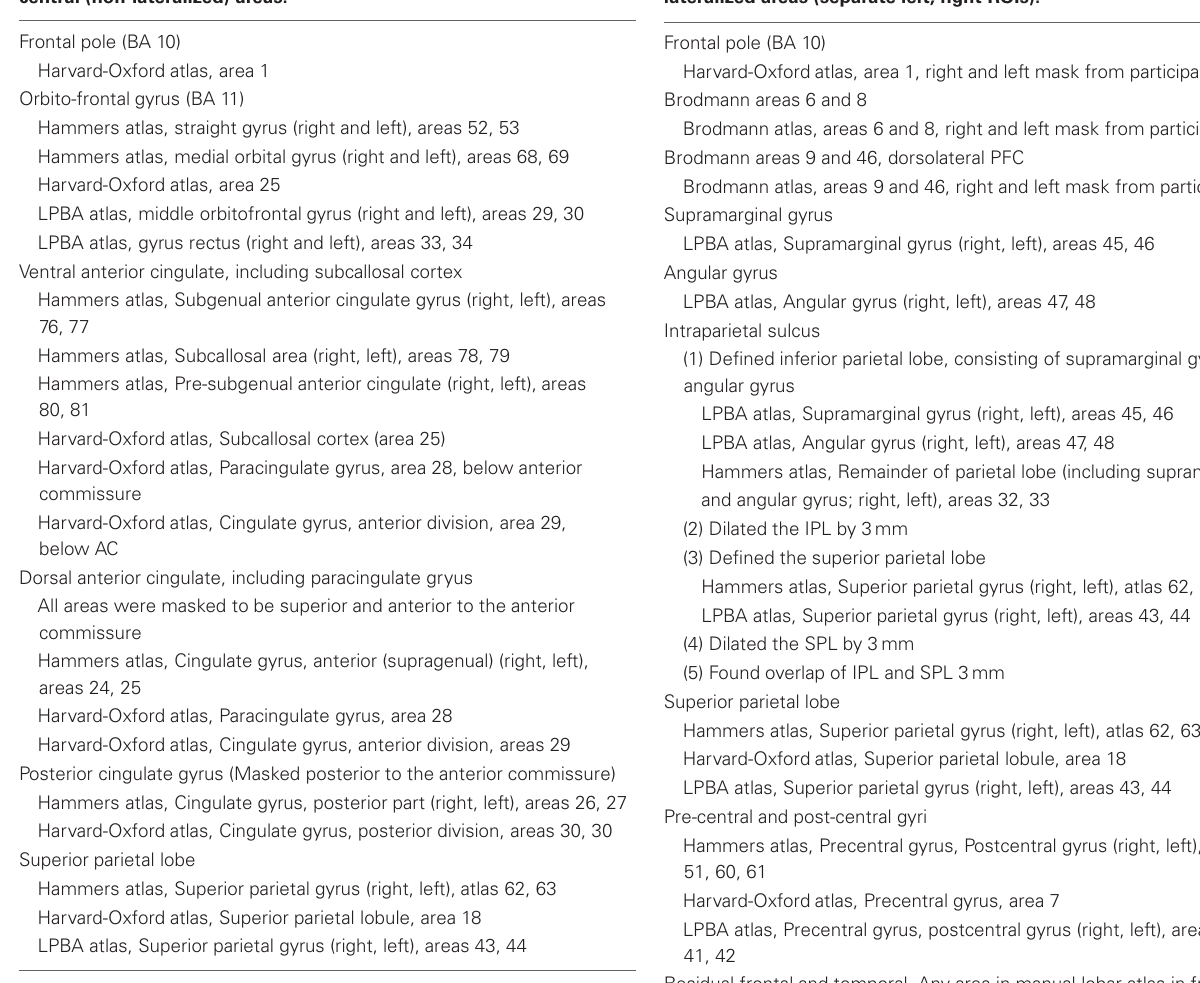
Table 2 | Regions-of-Interest for the individual participant atlases for central (non-lateralized) areas.